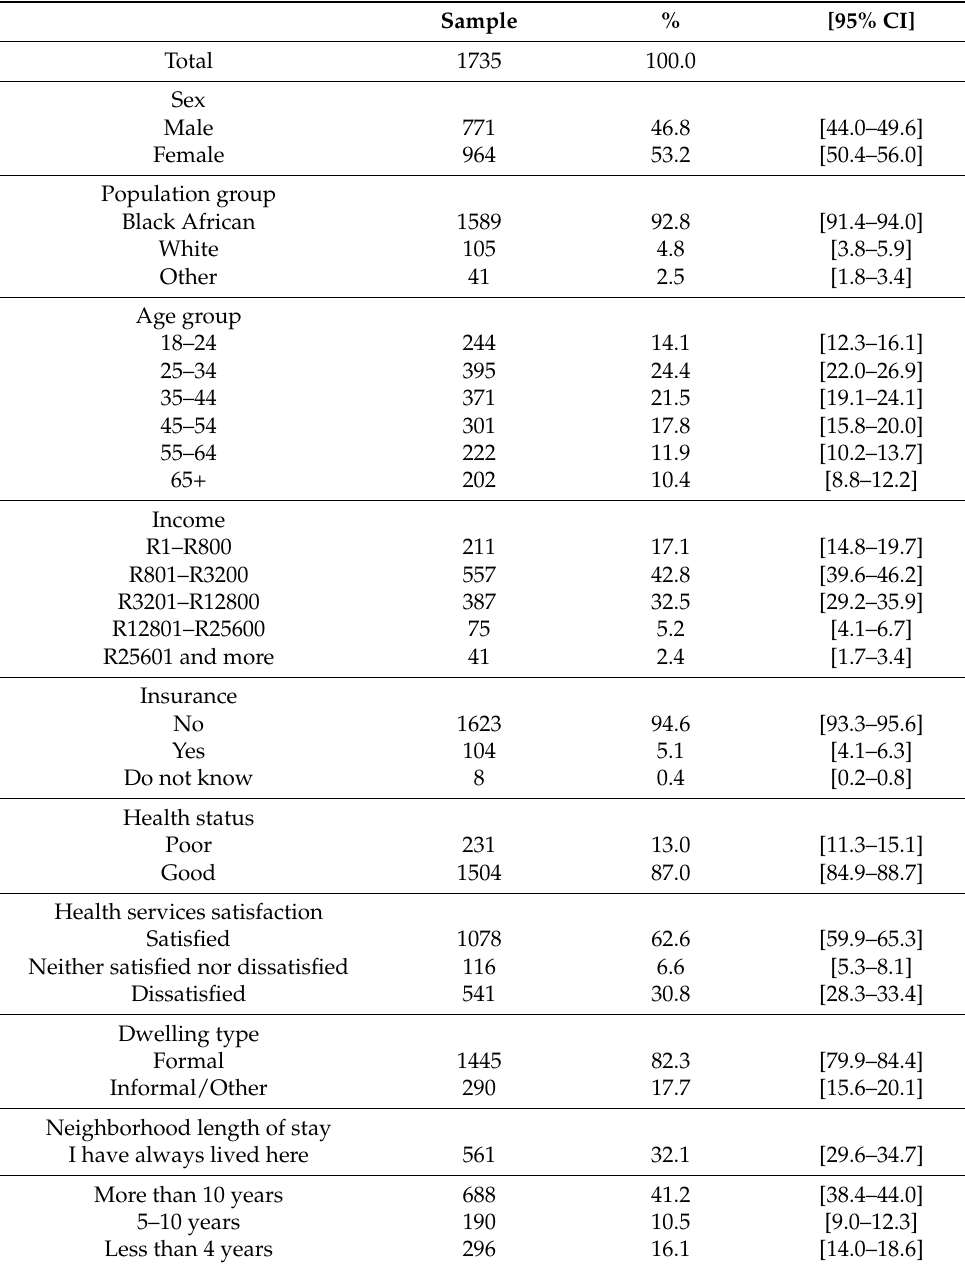
Table 2. Characteristics of the study